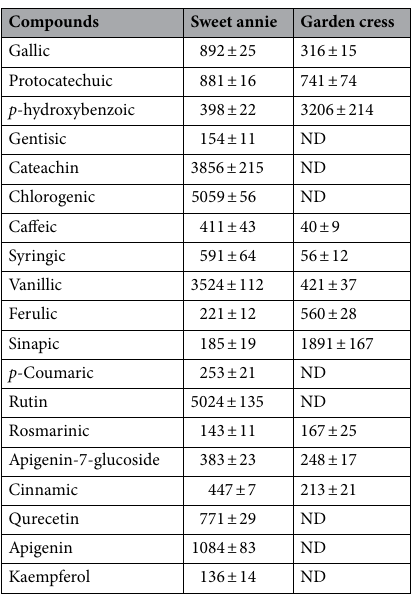
Table 1. Phenolic and flavonoids profile of aqueous A. annua and L. sativum extracts (μg/100 mL).